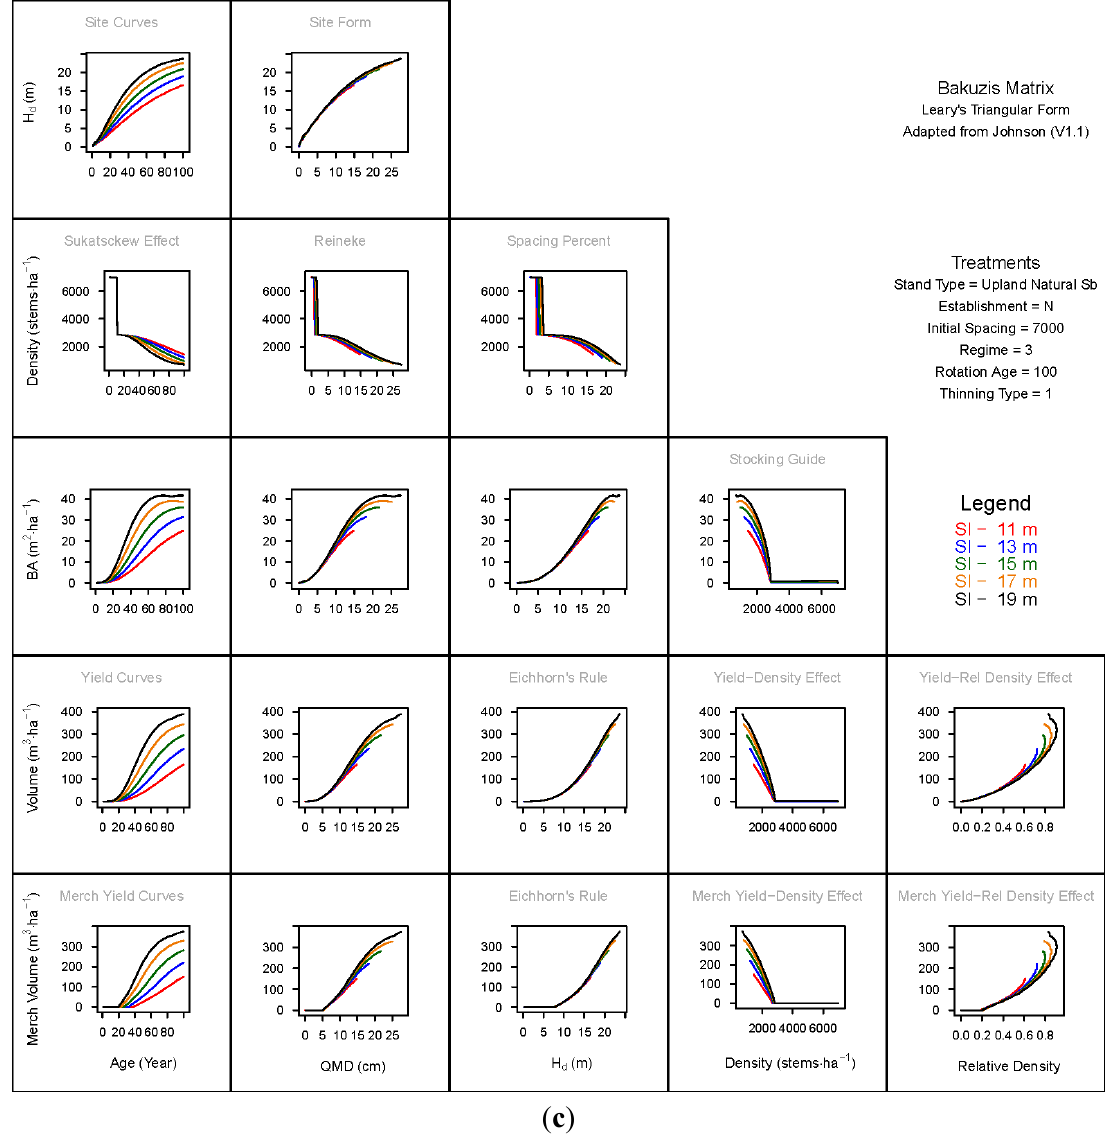
Figure 1. Bakuzis matrices for unthinned and precommercially thinned (PCT) upland black spruce (Sb) stands, which were established naturally (N) at an initial densities of 7000 stems/ha and grown on 5 site qualities (SI) over 100 year rotations: ( a ) Regime 1 represented unthinned control stands; ( b ) Regime 2 was initially identical to Regime 1 but the stands were subjected to a single PCT treatment at a stand age of 10 years in which stand densities were reduced to 2862 stems/ha and the maximum thinning response model setting was employed; and ( c ) Regime 3 was identical to Regime 2 but the stands utilized the minimum thinning response model to account for accelerated growth arising from the PCT